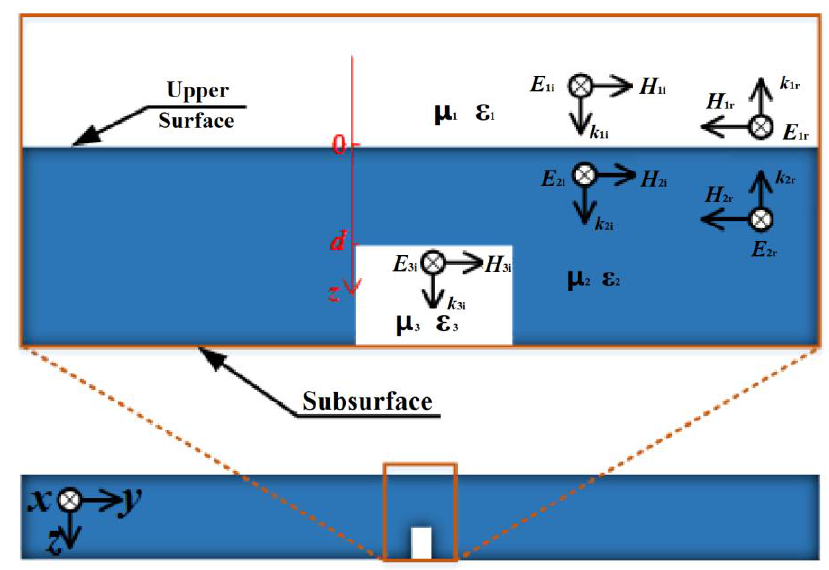
Figure 2. Magnetic characteristic of 20# steel.